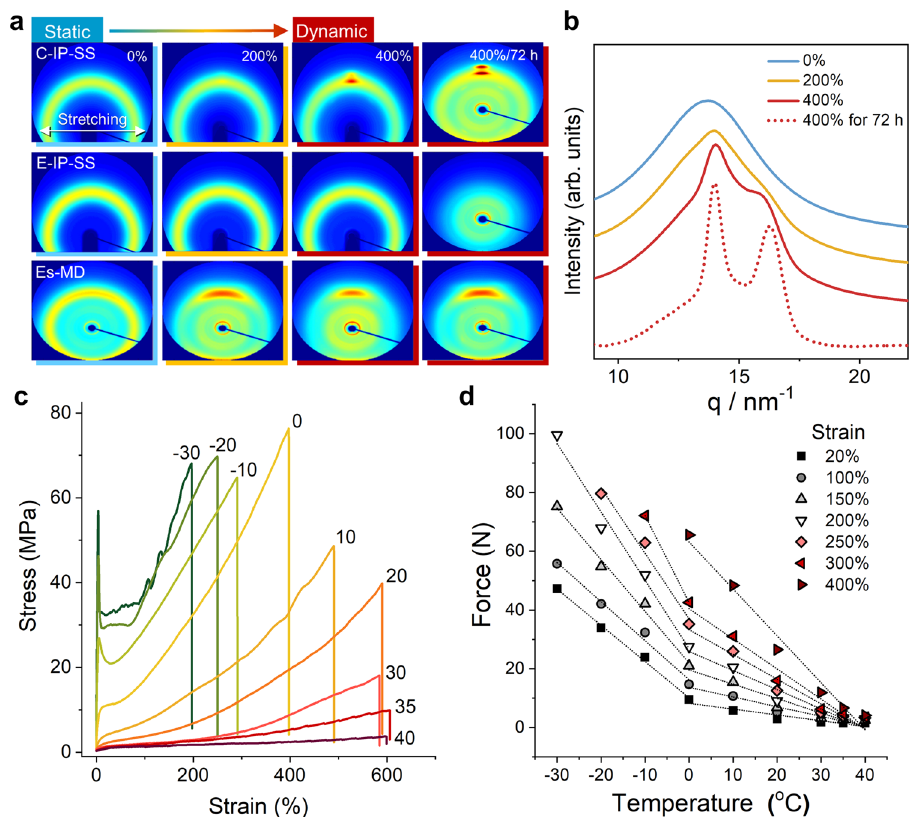
Fig. 6 X-ray and thermodynamic analyses of strain-induced phase transition. a , 2D WAXS images of three TPUs at stretching ratios of 0%, 200%, and 400%. The WAXS results of 400%-stretched samples and that were held for 72 h are also included to trace further structural evolution. b , 1D WAXS pro fi les of C-IP-SS at various degrees of stretching. c Stress – strain curves of C-IP-SS at various temperatures in the − 30 to 40 °C range. d Force versus temperature plots at various strains based on the stress – strain